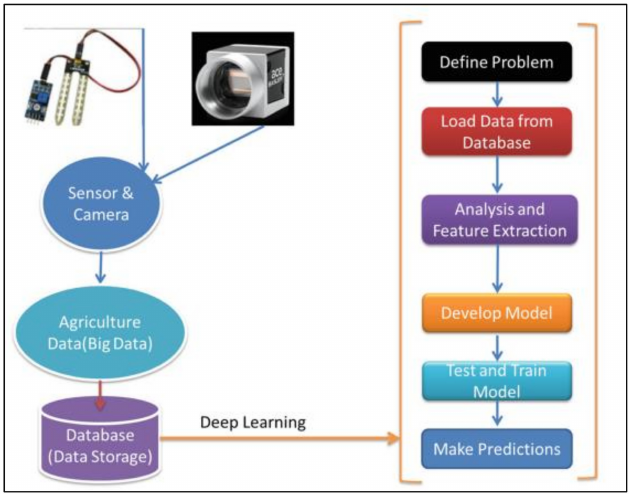
Figure 6. Deep learning approach for water management